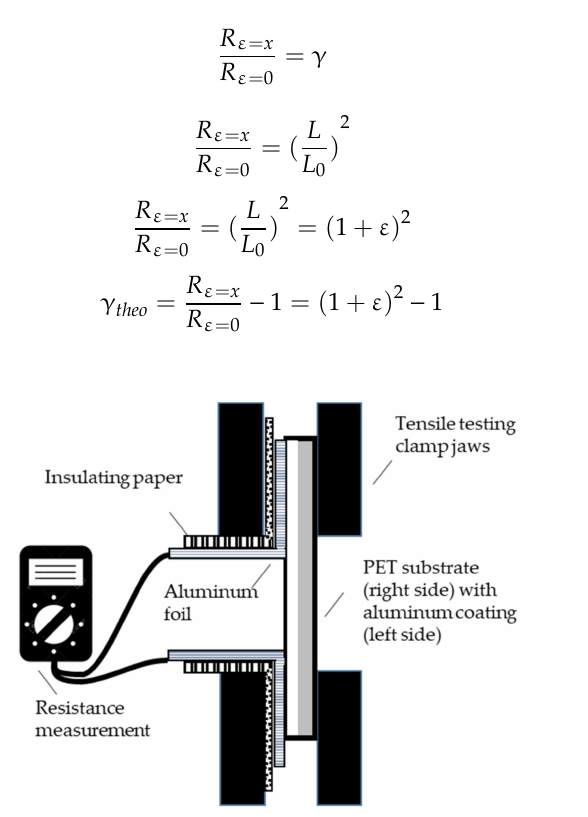
Figure 2. Measurement of increase in resistance γ during the tensile